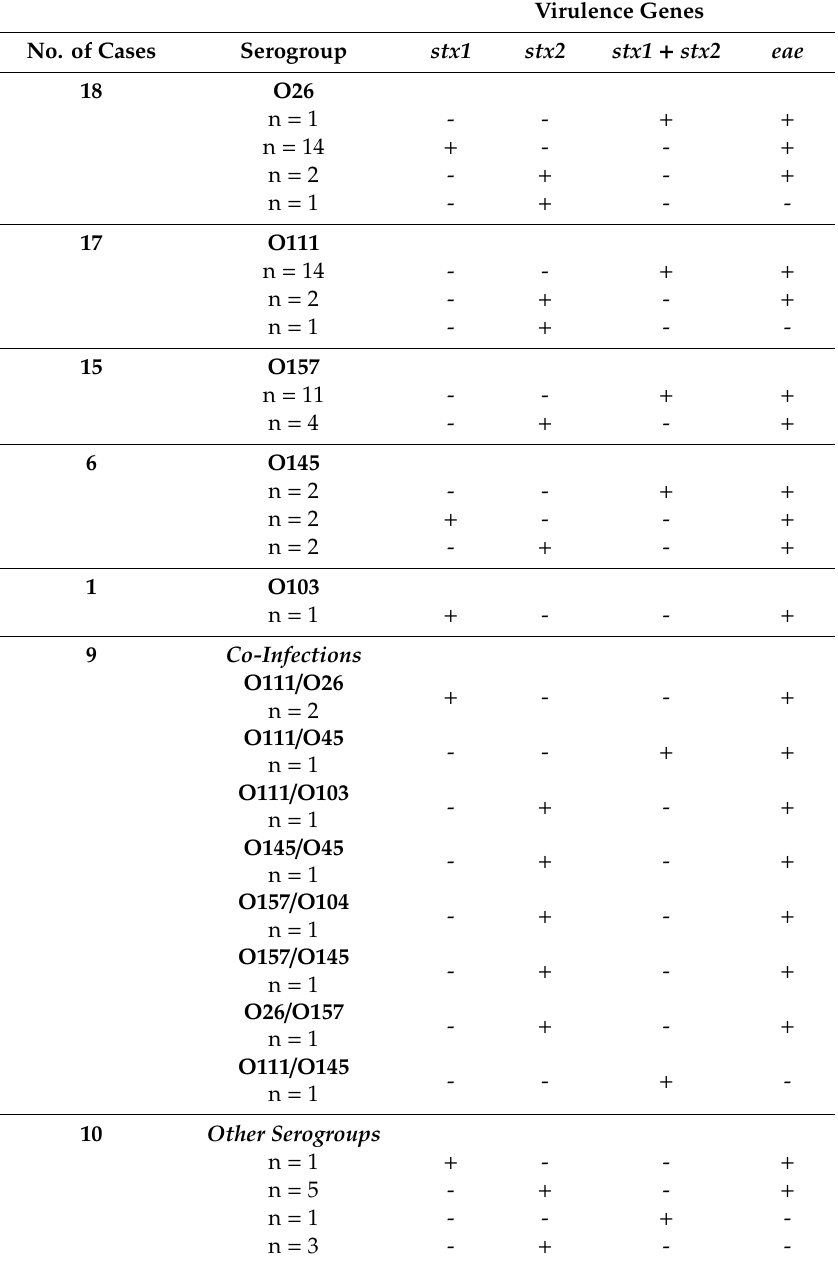
Table 1. Distribution of cases of STEC infection with identified virulence pattern (n = 76) by STEC serogroup and virulence genes, Apulia region, July 2018–August